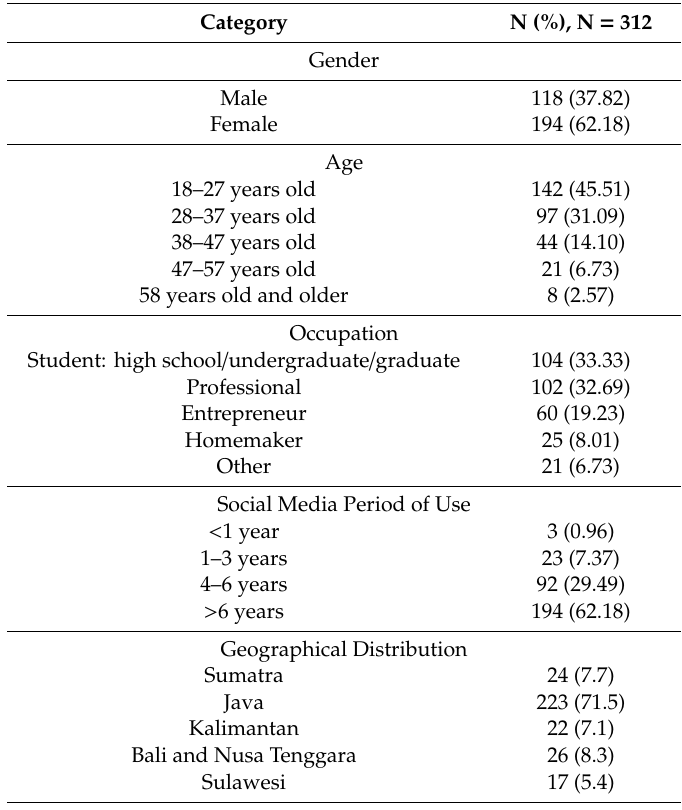
Table 1. Distribution of participants by demographic profile.